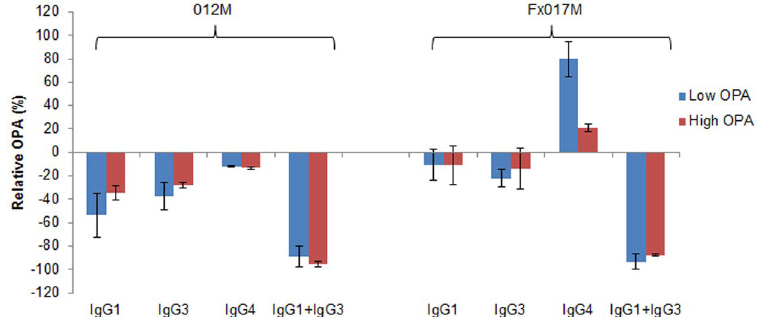
Figure 4. Serum opsonophagocytic activity following depletion of IgG isotype subclass antibodies. The change in peak OPA relative to the non-depleted sample, as measured by Mfreq, when the low-OPA and high-OPA pools from the 012M and Fx017M cohorts were depleted of IgG1, IgG3, IgG4, or IgG1 +